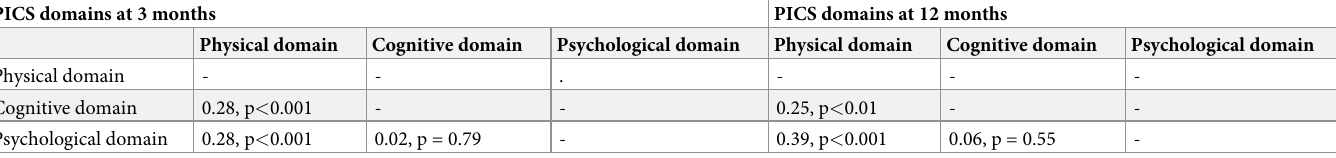
Note: Data reported in Pearson correlation coefficient